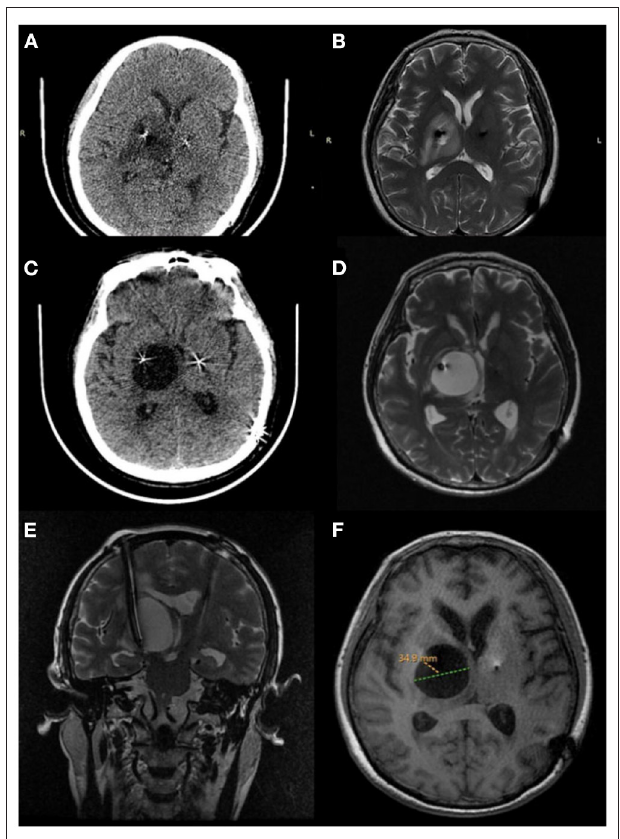
FIGURE 1 | Peri-lead edema 2 months after deep brain stimulation surgery. (A) Axial CT, (B) axial MRI T2. Cystic cavitation around the lead 4 months after deep brain stimulation surgery. (C) Axial CT, (D) axial MRI T2. Five months after deep brain stimulation surgery. (E) Coronal T2 (MRI) showing a large cyst, (F) axial T1 (MRI) the cystic cavitation with a maximum diameter of